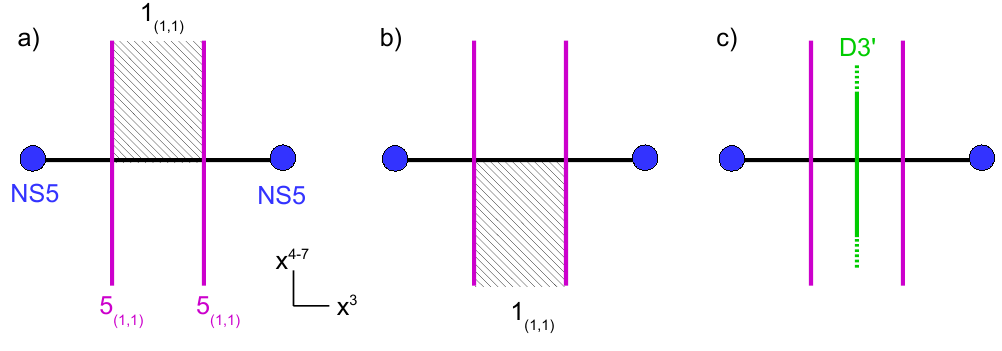
Figure 7 . Brane setups inserting: (a) u + , (b) u (cid:0) , (c) ’ 2 . The vertical axis corresponds to the direction spanned by the 5 brane in the x 47 (1 ; 1)